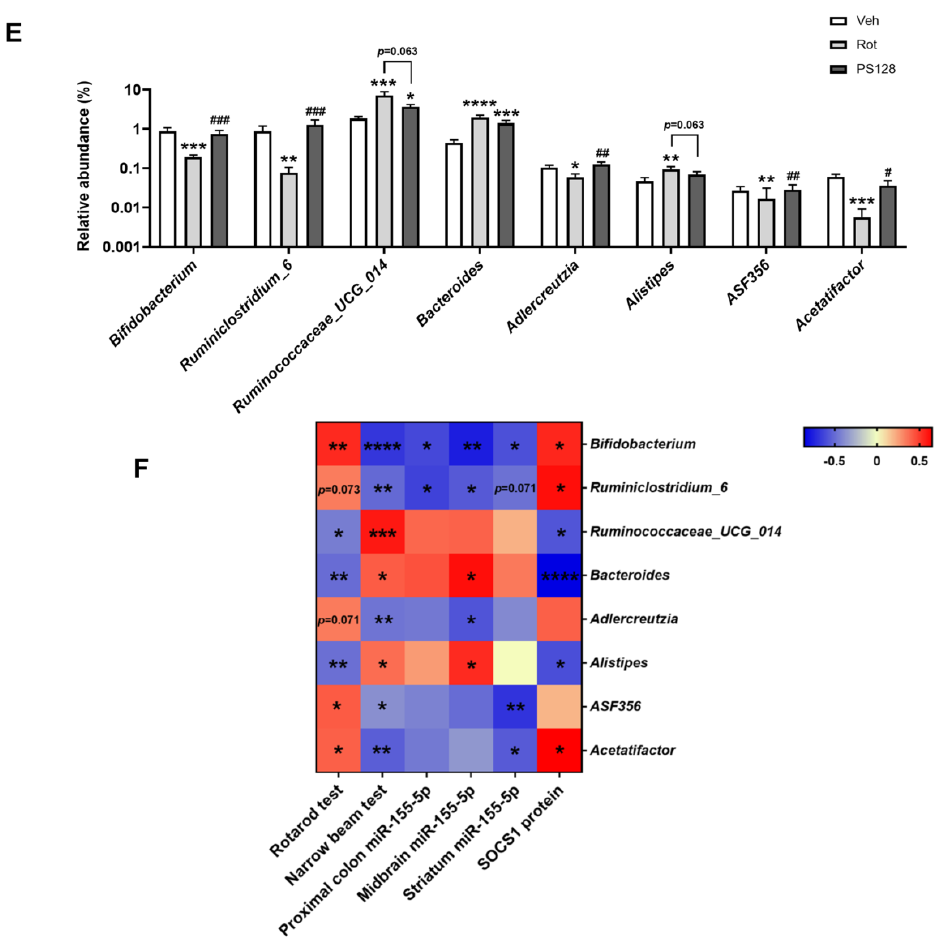
Figure 5. Effects of L. plantarum PS128 on the fecal microbiome in rotenone-induced PD-like mice. ( A ) Relative abundance of bacteria at the phylum level. Alpha diversity is indicated by Chao1 ( B ) and Simpson ( C ) diversity indices. ( D ) Beta diversity is indicated by nonmetric multidimensional scaling (NMDS). ( E ) Analysis of the relative abundance of bacteria at the genus level among all groups. N = 10 per group. ( F ) Heat map of the Spearman’s rank correlation test representing the correlation between bacteria at the genus level and behavioral performance, expression of miR-155-5p in different tissues, and midbrain expression of SOCS1. N = 10 per group in the correlation between bacteria with behavioral performance; n = 5 per group in the correlation between bacteria with tissue expression of miR-155-5p and midbrain expression of SOCS1. * p < 0.05, ** p < 0.01, *** p <